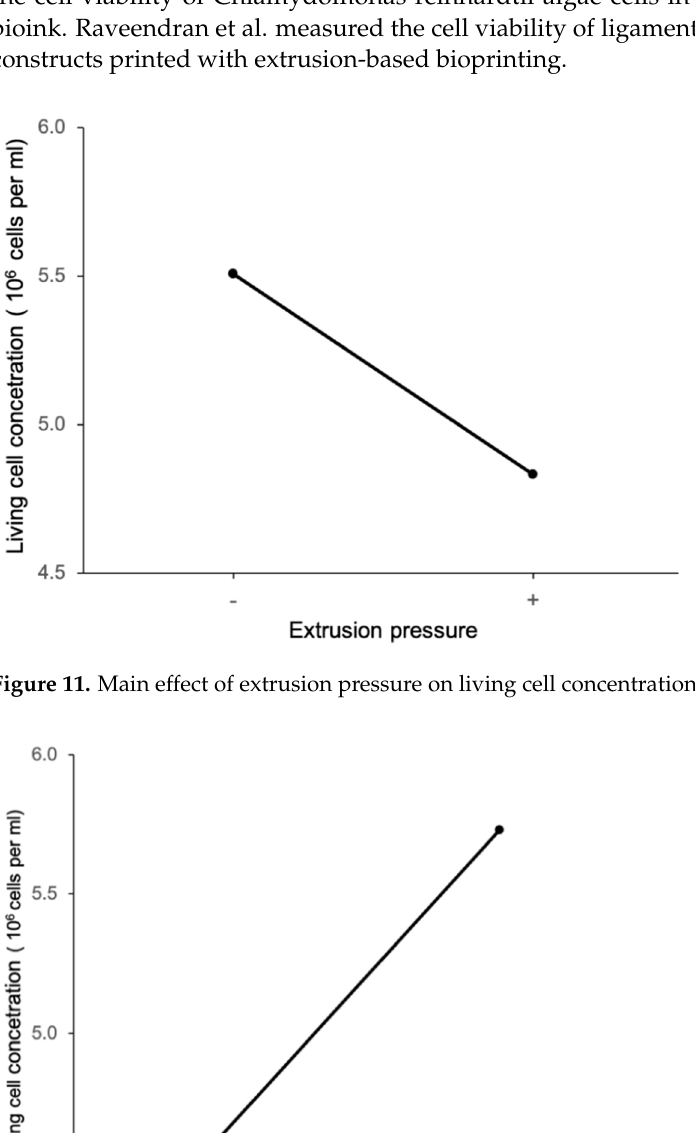
Figure 13. Main effect of bioink composition on living cell concentration.